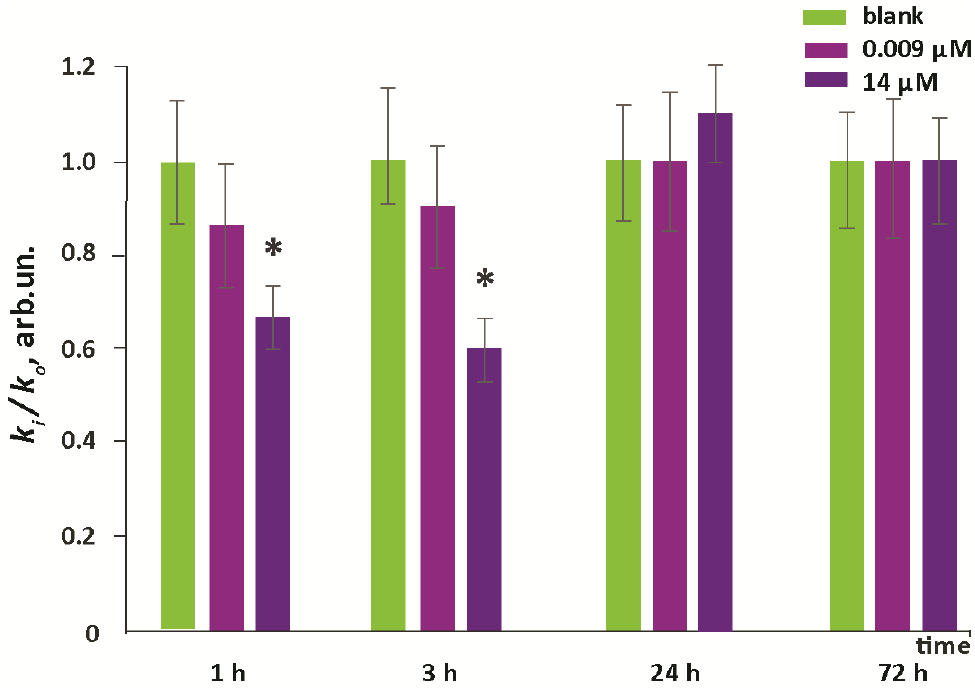
Figure 4. Histograms of ROS levels in cells (the ratio of DCF synthesis rate constants k i to the control value k 0 ) at various F1 concentrations and incubation times (indicated in the figure). Significant differences with the control by the Mann − Whitney test ( p < 0.01) are denoted by “*”.